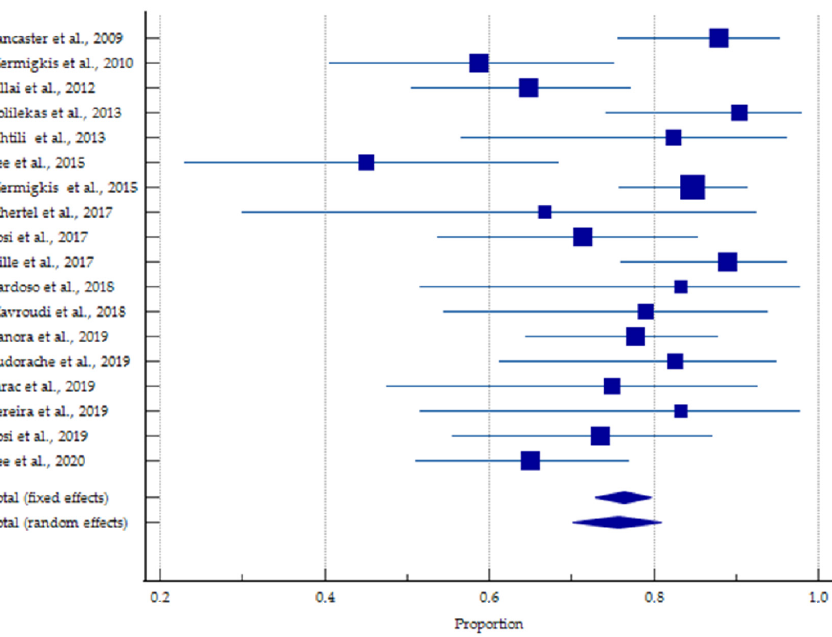
Figure 2. Forest plot of the prevalence of obstructive sleep apnea among patients with idiopathic pulmonary fibrosis patients. Each square represents the effect estimate of a single publication, while horizontal lines represent a 95% confidential interval. The size of squares is proportional to the weight of each paper in the meta-analysis [5,31–47]. Exact data are available as Supplementary Table